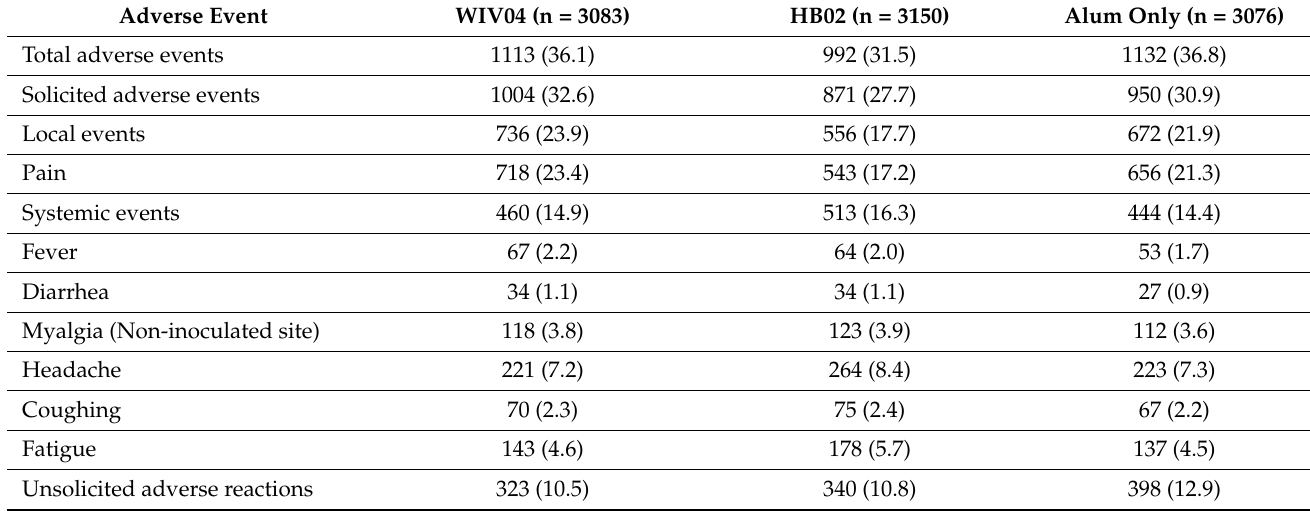
Table 4. Common Adverse Reactions and Grades in the Safety Analysis